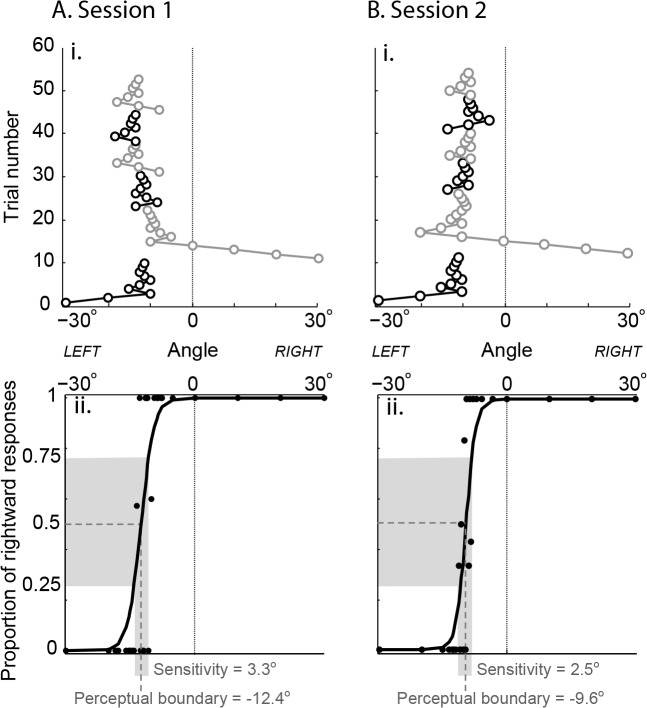
Adaptive staircase performance of an older subject (age 56) in two sessions conducted 7 days apart.
A. i. Subject performance on 6 staircases in session 1: trial number vs. angle of the white line relative to true index finger angle (0°). Black: staircases that began with a leftward trial. Grey: staircases that began with a rightward trial. ii. Proportion of rightward responses at each tested angle (black circles) with fitted function. Perceptual boundary (proprioceptive bias) was -12.4°, proprioceptive sensitivity (width of grey shaded area on x-axis) was 3.3°. B. i. Subject performance 7 days later on 6 staircases. ii. Both perceptual boundary and sensitivity (-9.6° and 2.5°, respectively) appear similar to the first session.